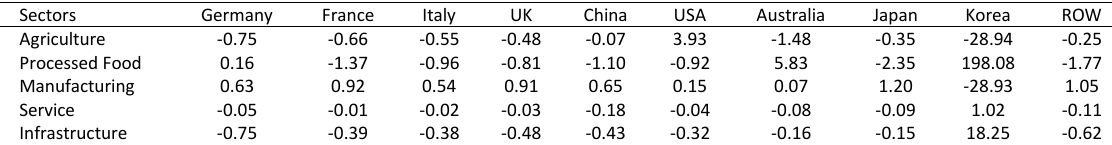
Table 6: Change in output volume by sector (%)